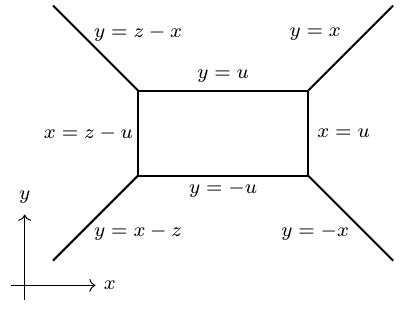
Figure 5 . Amoeba of the curve